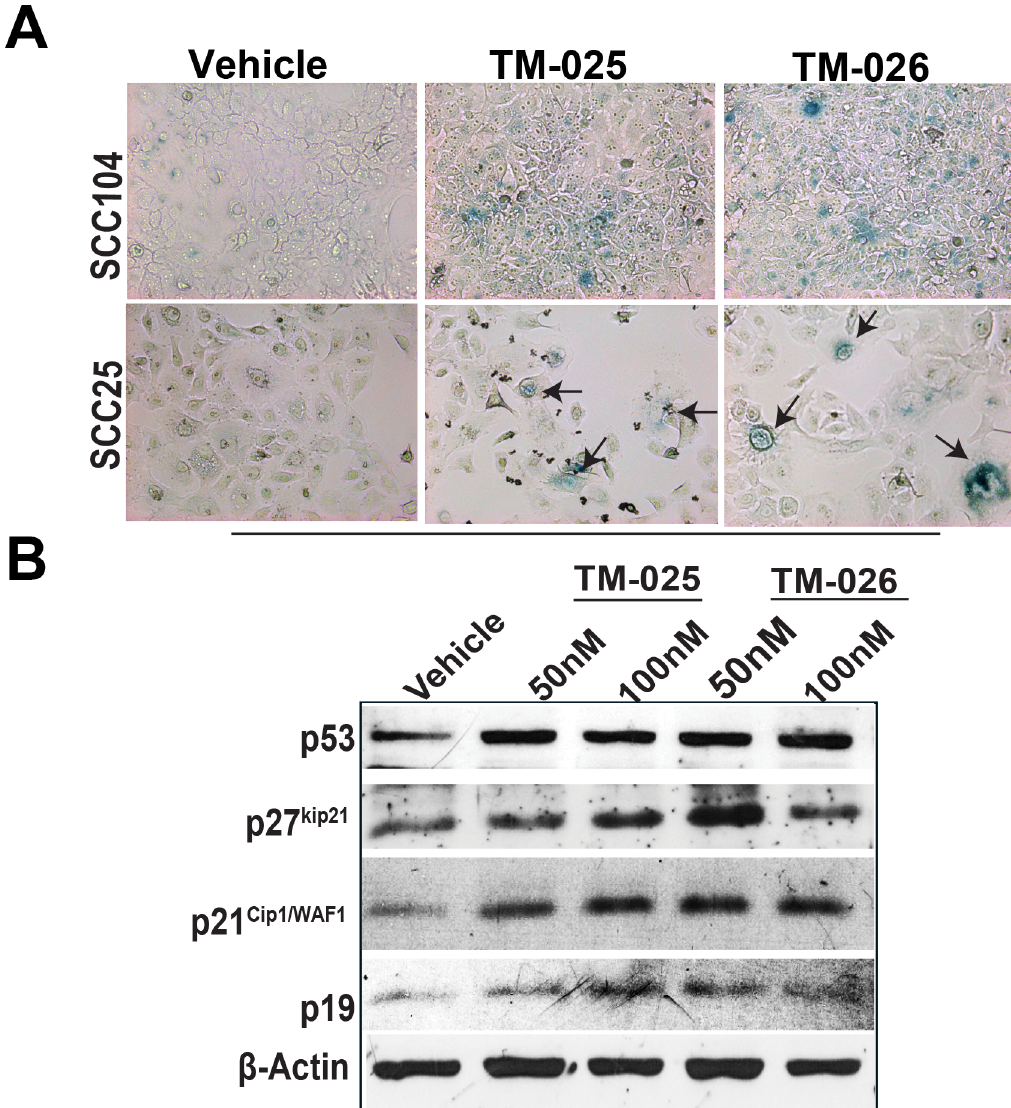
Fig 5. PCT analogs caused senescence in SCC25 and SCC104 cell lines by upregulation of p53, p21 Cip1/WAF1 and p27 kip21 . (A): SCC25 and SCC104 cells were treated with DMSO (vehicle), 100 nM of TM-025 and TM-026 for 3 days, followed by SA- β -gal staining. A prominent onset of senescence (blue) was observed in both cell lines. (B): Western blots showing activation of p53, p21 Cip1/WAF1 and p27 kip21 by 50 and 100 nM of the PCT analogs. Quantifications are shown in S4 Fig Part